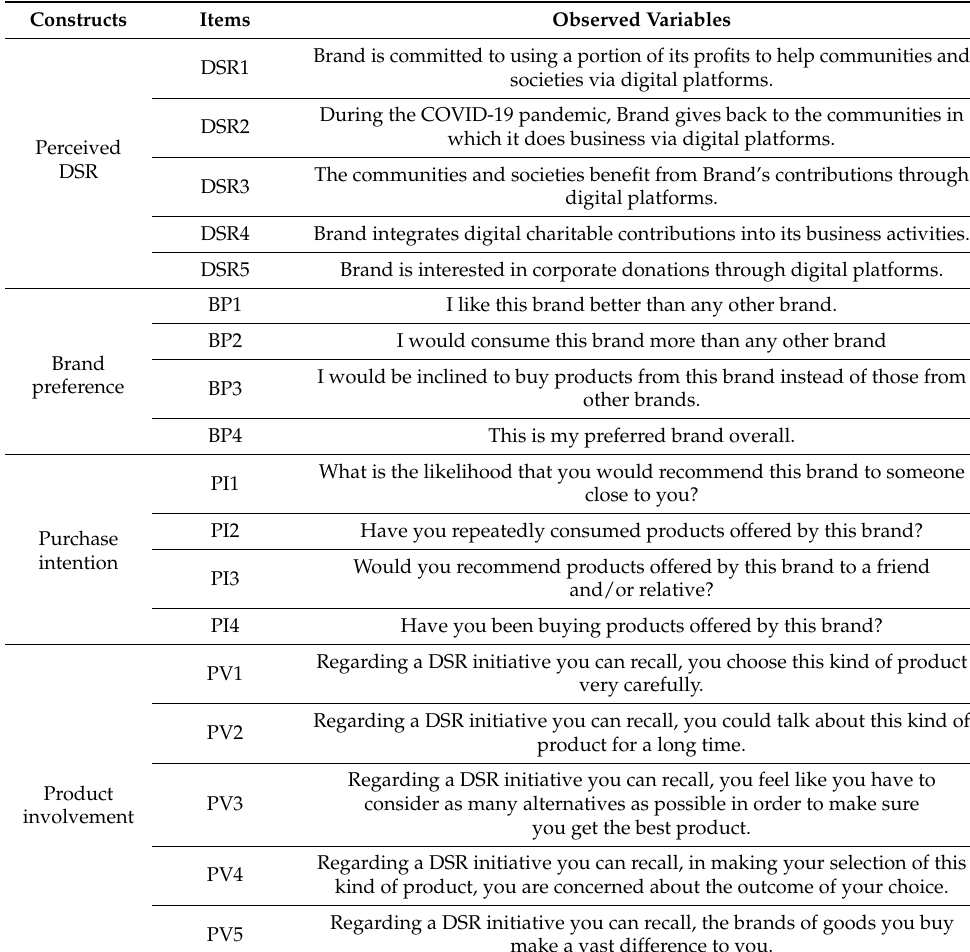
Table 1. Questionnaire constructs and